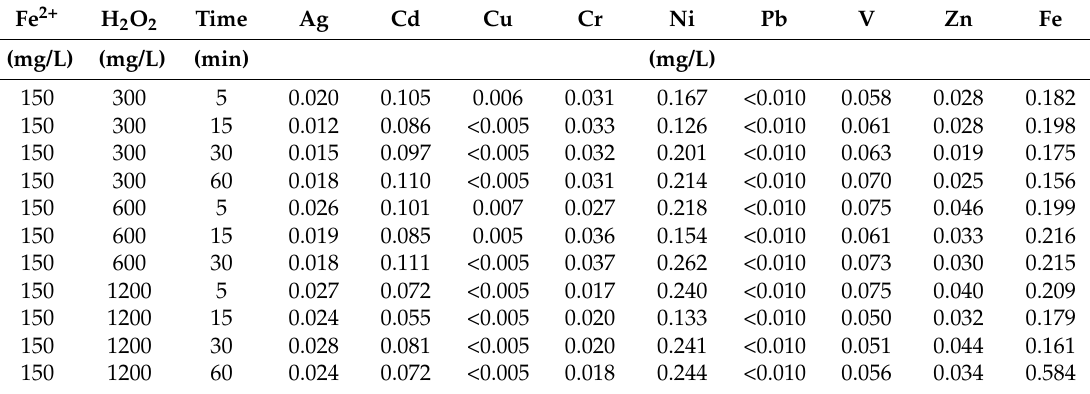
Table 3. Heavy metals concentration after Fe 2+ /H 2 O 2 process without sedimentation. Fe